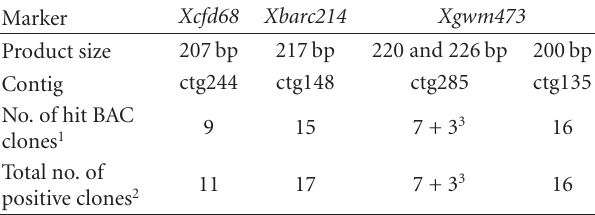
Table 2: Results of 7DS library screening with microsatellite markers Xcfd68 , Xbarc214, and